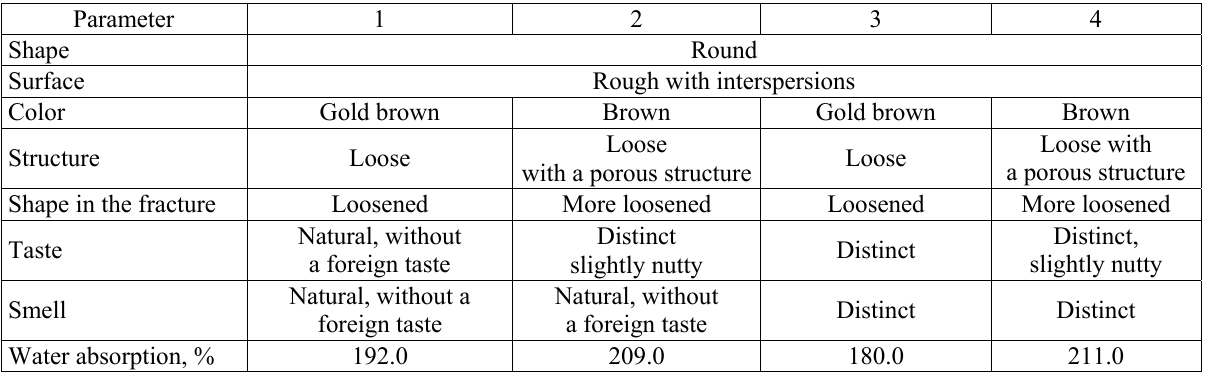
Table 4. Quality parameters of products (numbers 1–4 of products are according Table